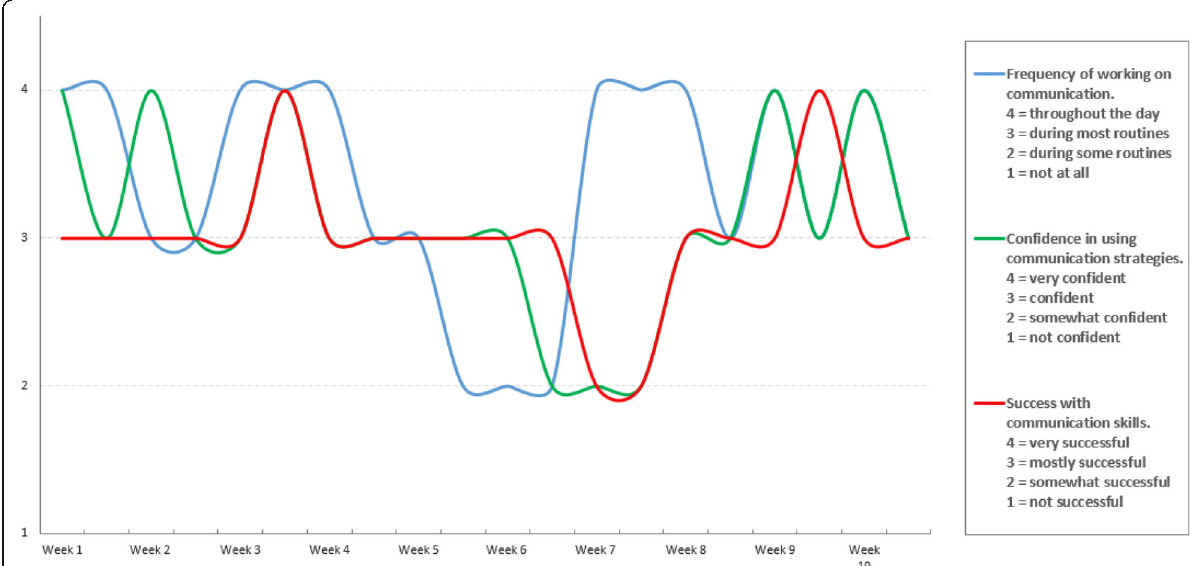
Fig. 2 Personalized longitudinal report of patient reported outcomes in a single patient, TAILOR Early Intervention pilot project example. Caption: This figure illustrates the longitudinal data shared by an example parent during use of the TAILOR tool while receiving Early Intervention services, showing variability in data over time and enabling the provider and patient to discuss needs for refining the treatment approach. The data includes periodic snapshots of three dimensions: the frequency of work on a skill area; parent confidence in working on the skill; and child ’ s success in the skill